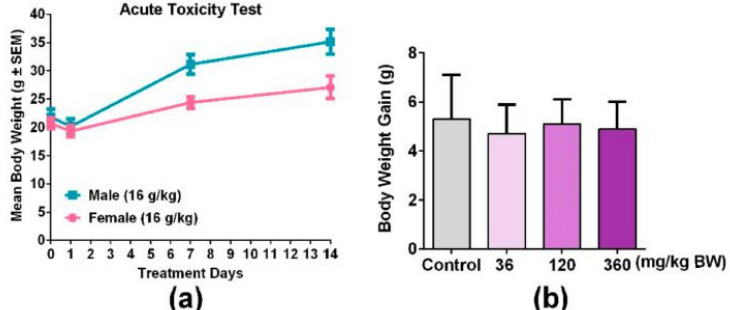
Figure 3. GPP orally administered did not show significant changes in the body weight of mice. ( a ) Male mice and female mice were treated with 16.0 g / kg BW GPP twice per day for 14 days, and the body weight of both genders of mice were recorded on the 0, 1, 7, and 14th day (N = 10). ( b ) Body weight gain of mice after being treated with 36, 120, 360 mg / kg BW of GPP for 30 days in four groups (N = 12). Data were expressed as mean ± SEM.